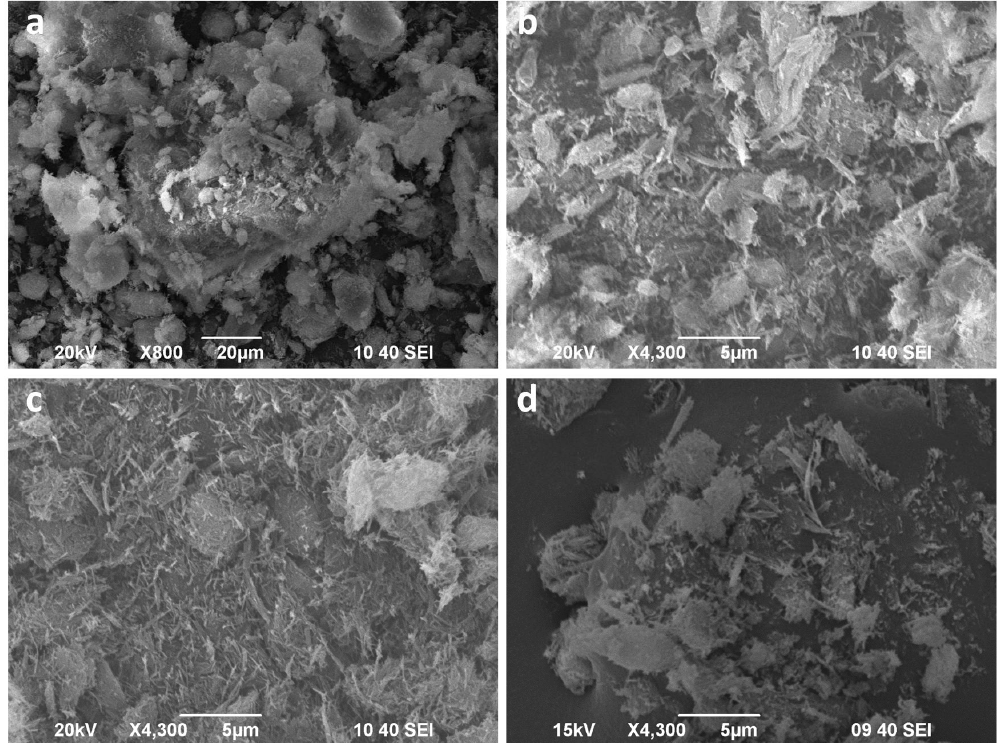
Figure 5 . SEM micrographs of natural Sp ( a ), Sp–H ( b ), Fe–Sp ( c ), and Fe–Sp–H ( d ).